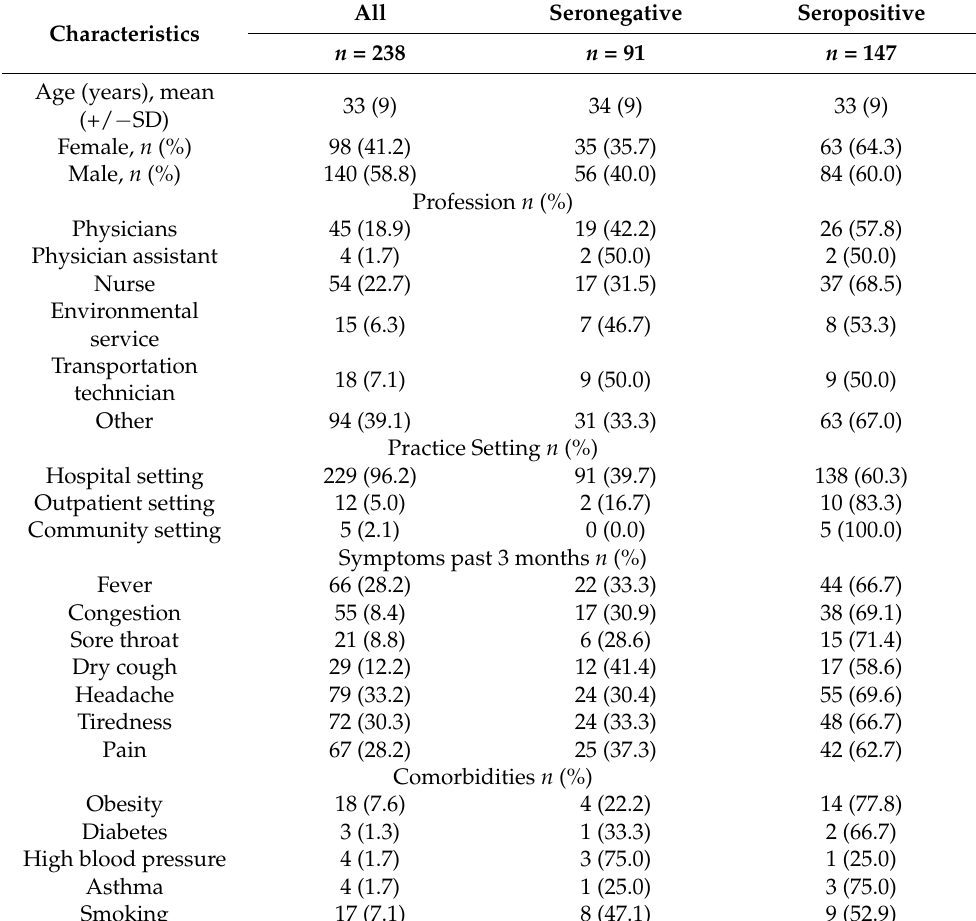
Table 1. Demographics and symptomatology of seropositive and seronegative participants.